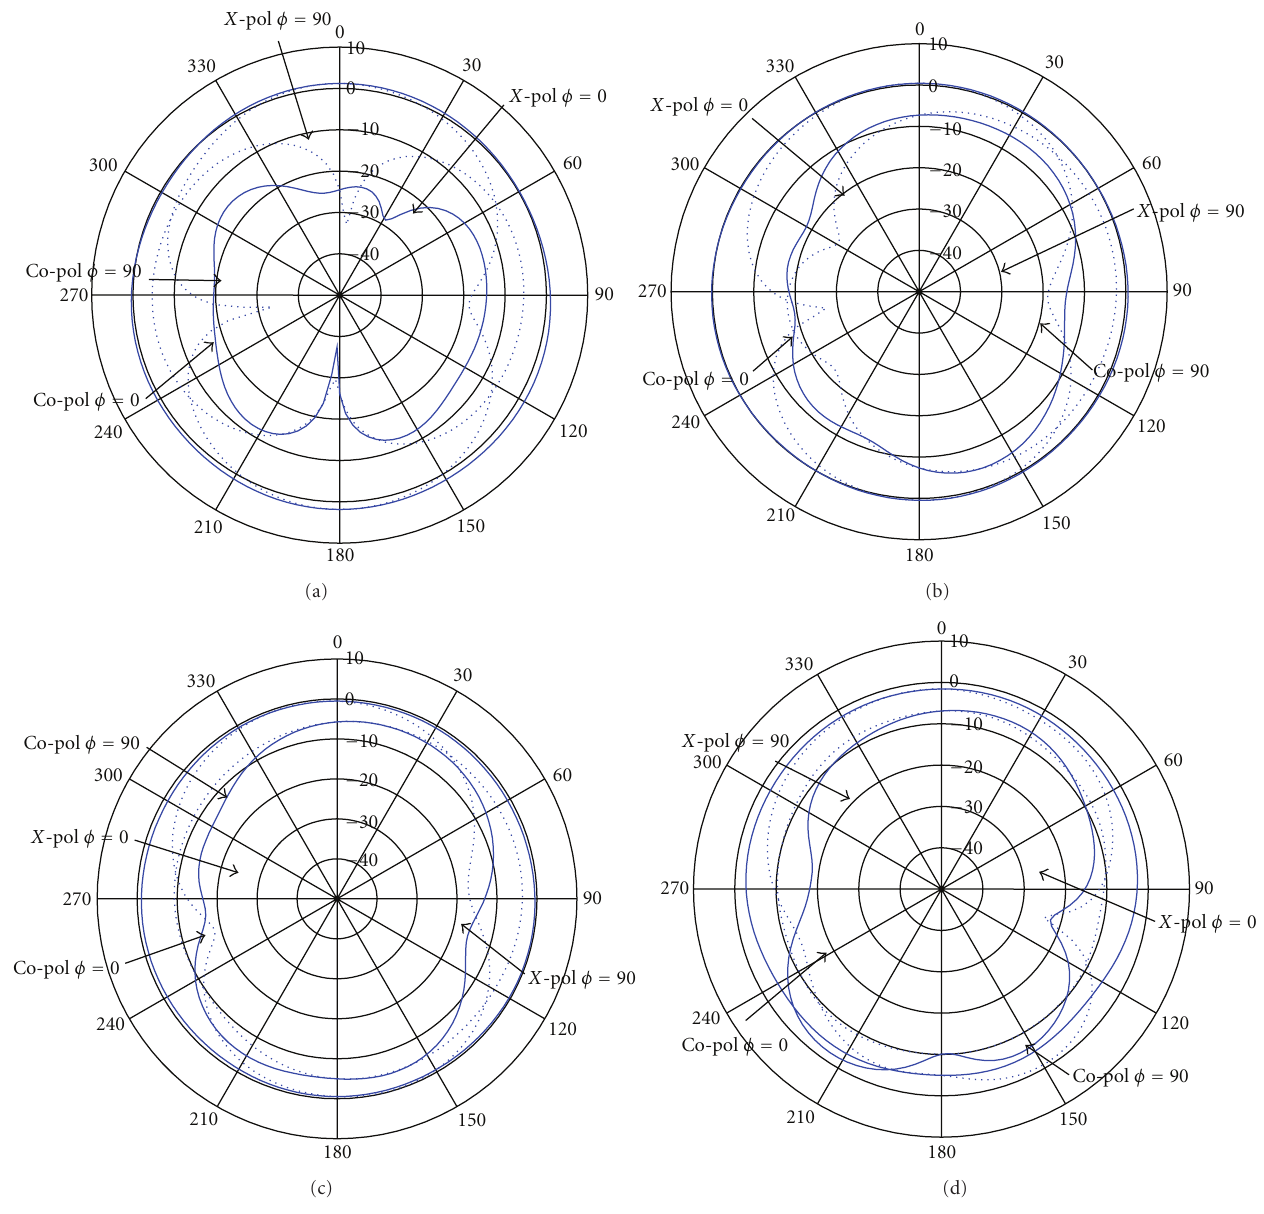
Figure 5: (a) Measured radiation patterns with N = 1. (b) Measured radiation patterns with N = 16. (c) Measured radiation patterns with N = 32. (d) Measured radiation patterns with N =